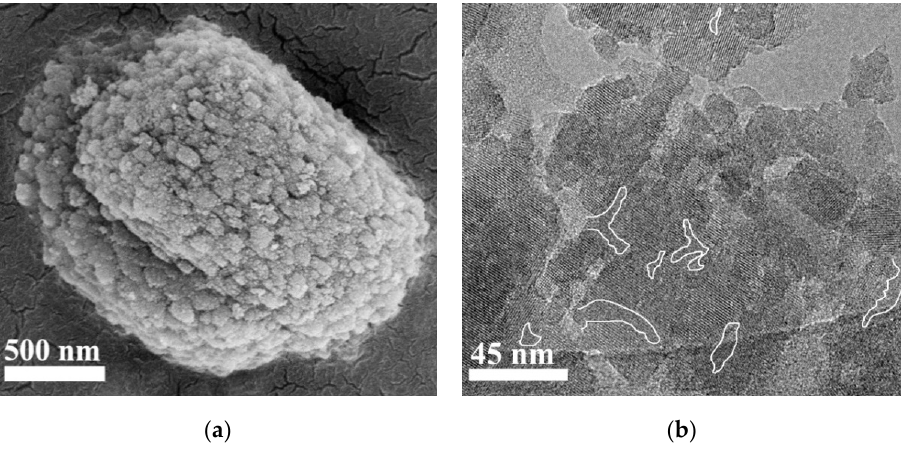
Figure 2. ( a ) Scanning electron microscope (SEM) and ( b ) transmission electron microscope (TEM) images of the ZSM-5-M sample.